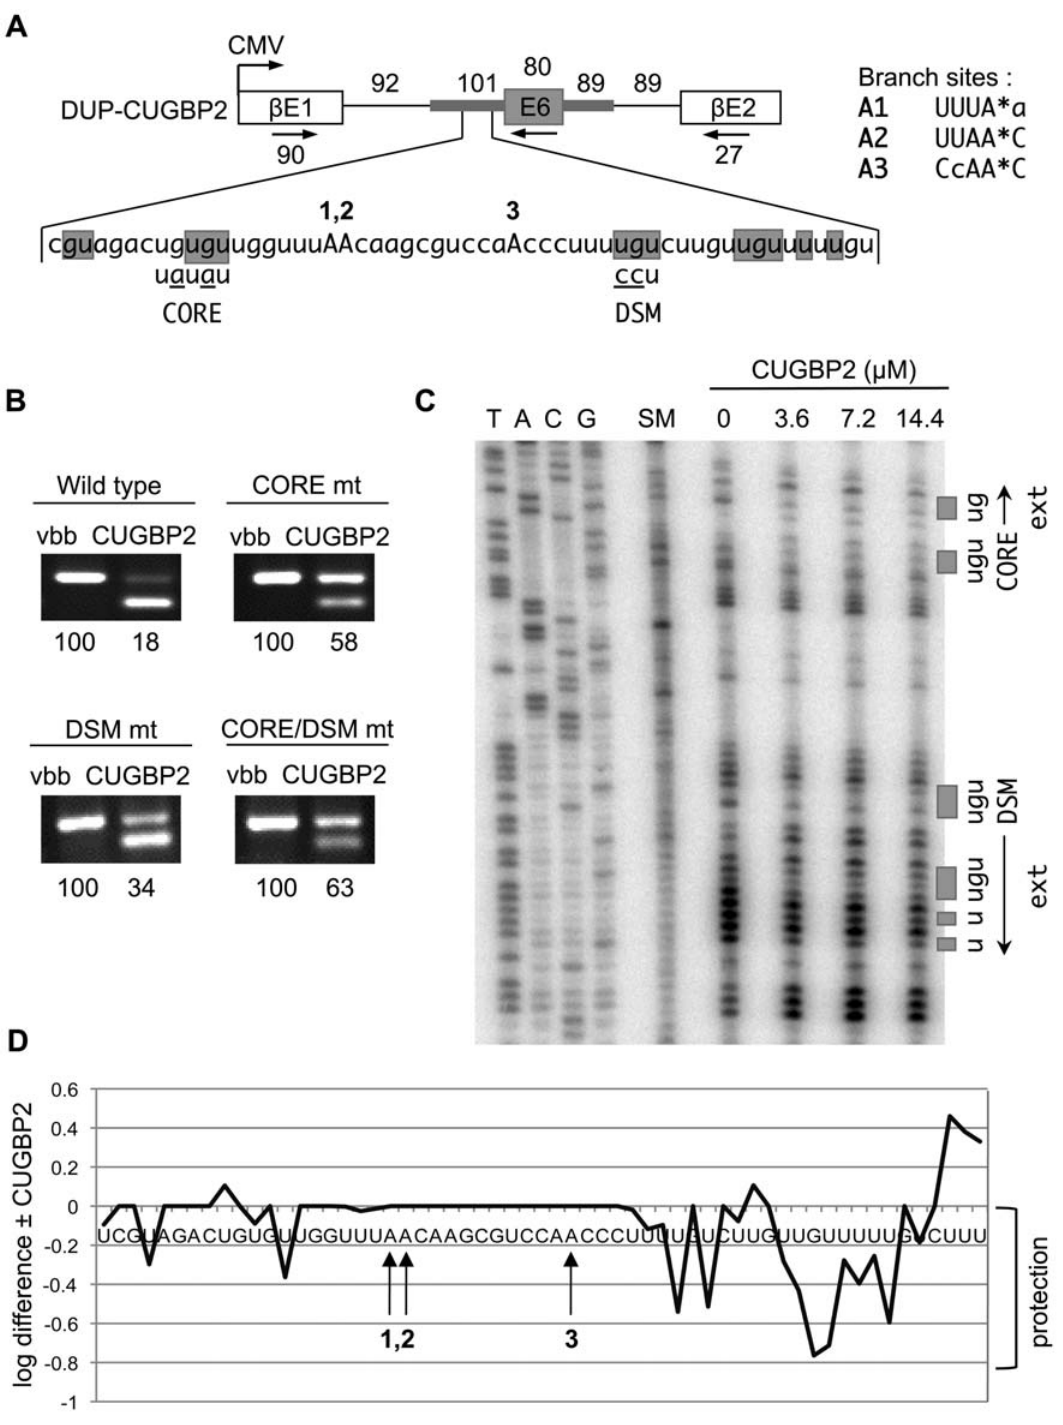
Figure 6. CUGBP2 is autoregulated by silencing from exon 6 branch site perimeters. (A) Splicing reporter with sequence showing predicted branch sites (A1, A2, A3) and CUGBP2 binding motifs (shaded regions). Primers (arrows) used for RT-PCR ( b E1 and b E2) or footprinting analysis (E6) are shown. Mutations in core (CORE) and downstream (DSM) motifs are indicated. (B) Autoregulation of E6 depends upon CUGBP2 binding motifs surrounding the branch site region. Gel panels represent RT-PCR analysis of the wild type or mutant derivatives of the splicing reporter co-expressed with vector backbone control (lanes vbb) or CUGBP2 protein expression vector (lanes CUGBP2) in HEK293T cells. Percent exon inclusion values are shown below gel panels. (C) Footprinting analysis of the predicted branch site region upstream of E6 of CUGBP2 pre-mRNA. Starting material (lane SM), or RNA treated with CMCT in the absence (lane 0) or presence (lanes 3.6, 7.2, 14.4 m M) of CUGBP2 protein. Protected regions are indicated as shaded boxes at right with extended regions of protection (ext) from the CORE or DSM motifs indicated by arrows. (D) Log difference of the band intensities of modified nucleotides in the absence or presence of 14.4 m M CUGBP2. Negative values represent regions protected by CUGBP2. Note that the strength of protection decreases with increasing distance from the primer used for primer